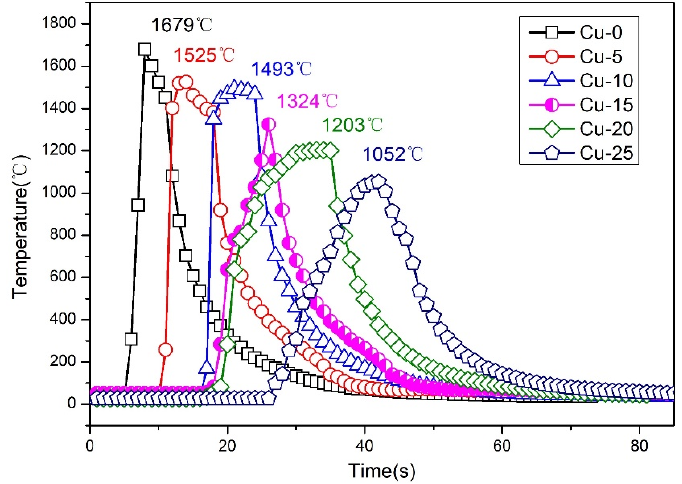
Figure 2. Real temperature curves of all samples during SHS reaction.